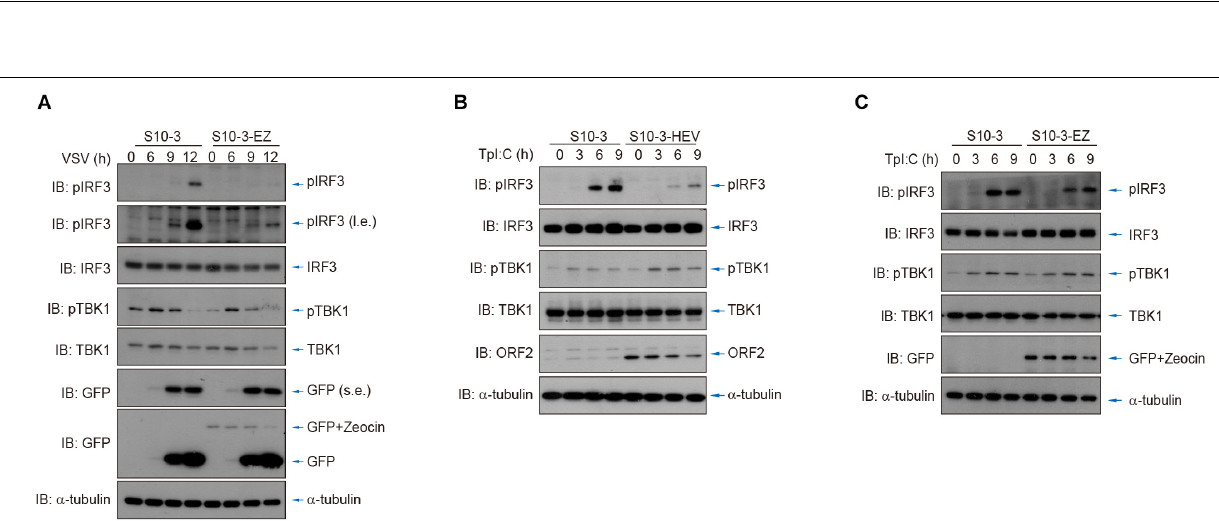
Frontiers in Microbiology |